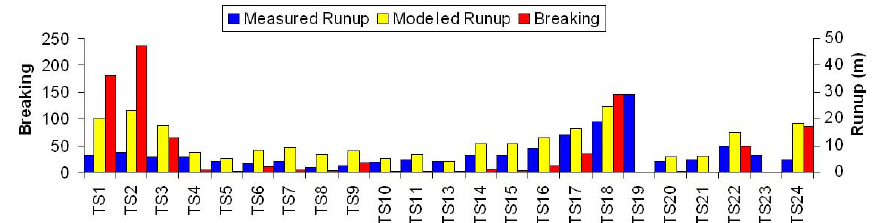
Fig. 9. Measured and modeled runup, and wave breaking analysis. Points where wave breaking is significant have the largest discrepancy between the measured and modeled wave runup (see Fig. 8).